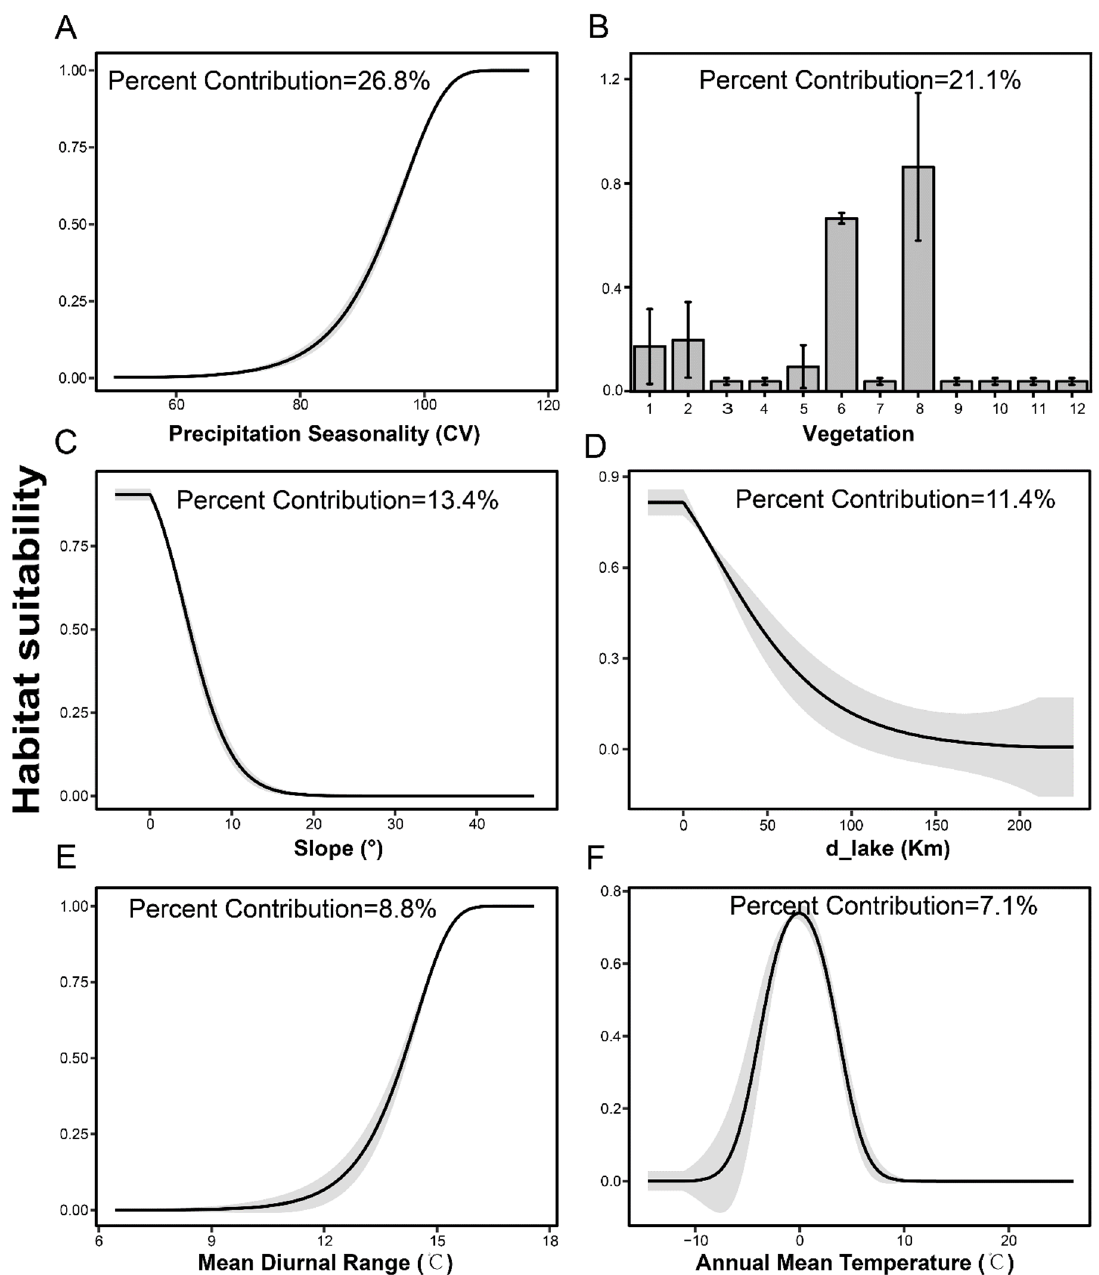
Figure 2. Response curves of habitat suitability for the black-necked crane (vertical axis) to Precipitation Seasonality( A ), Vegetation ( B ), Slope ( C ), d-lake ( D ), Mean Diurnal Range ( E ), and Annual Mean Temperature ( F ) showing as means (black lines) with standard deviation (SD, gray buffers) except Vegetation ( B ). The abscissa axis’s 1–12 of Vegetation ( B ) refers to (farmland, agroforestry, broad-leaved forest, coniferous forest, shrub, meadow, desert, wetland, urban areas, bare areas, water bodies, and glacier) respectively.